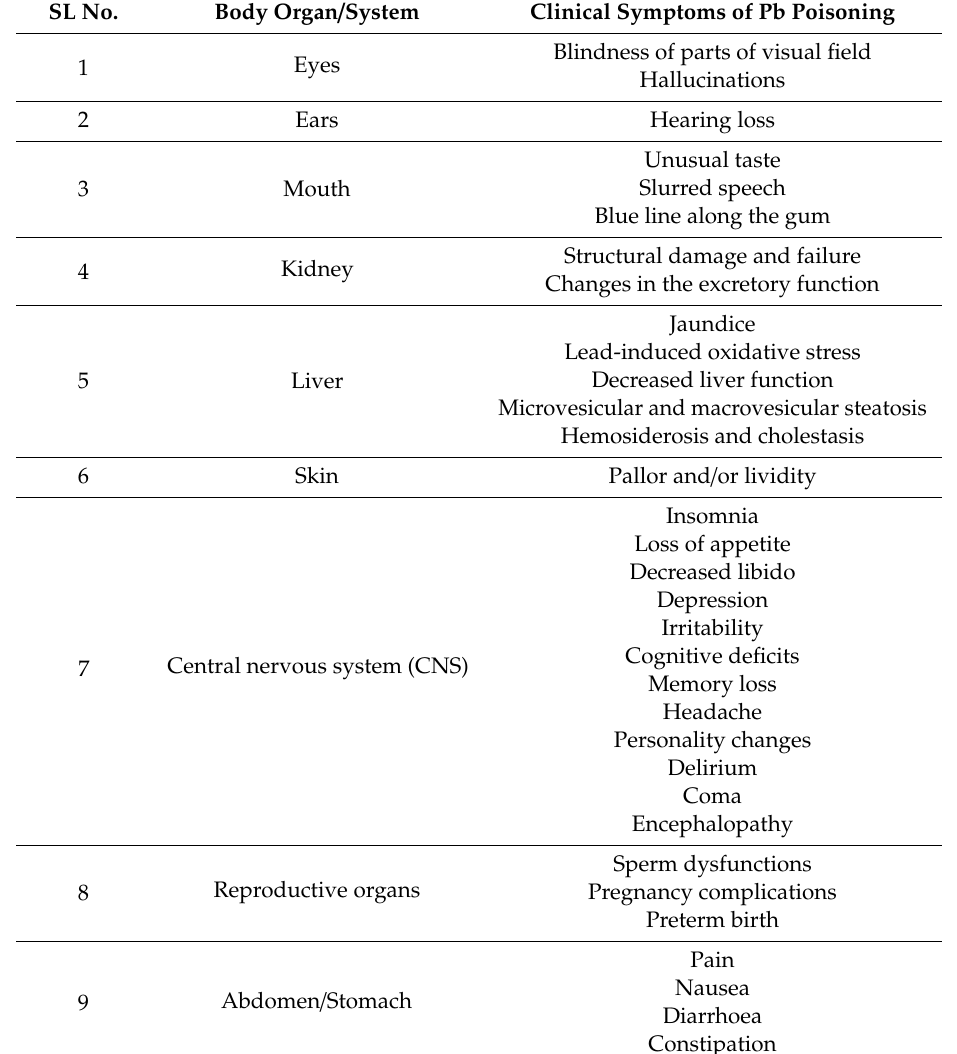
Table 6. Generalized clinical symptoms of Pb poisoning in